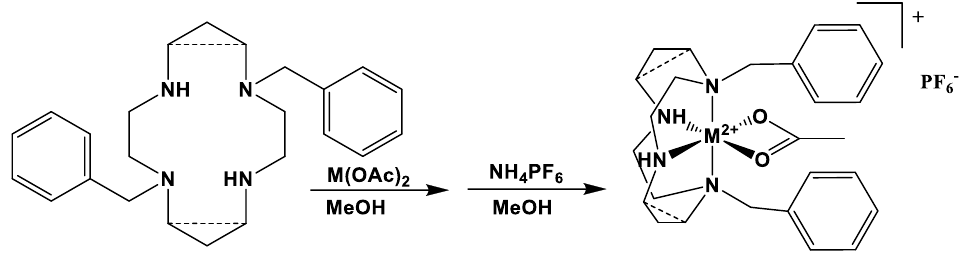
Figure 18. Metal complexation